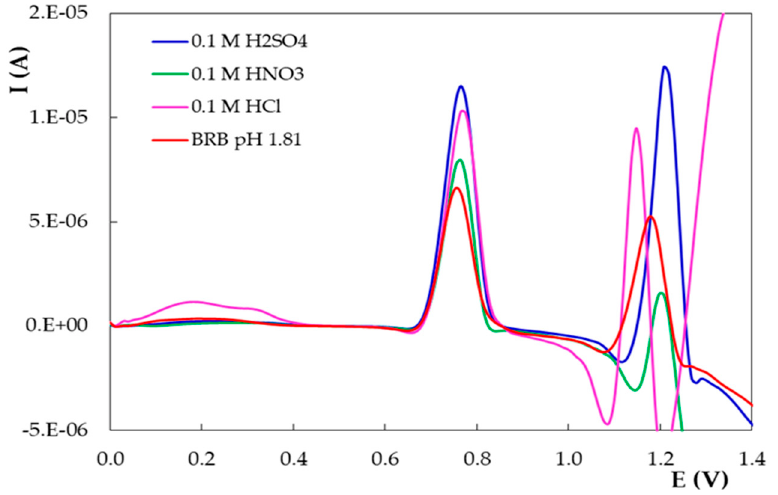
Figure 6. Differential pulse voltammograms recorded on PGE_H for 1.00 × 10 − 5 mol/L DIO in dif ‐ ferent acidic supporting electrolytes.